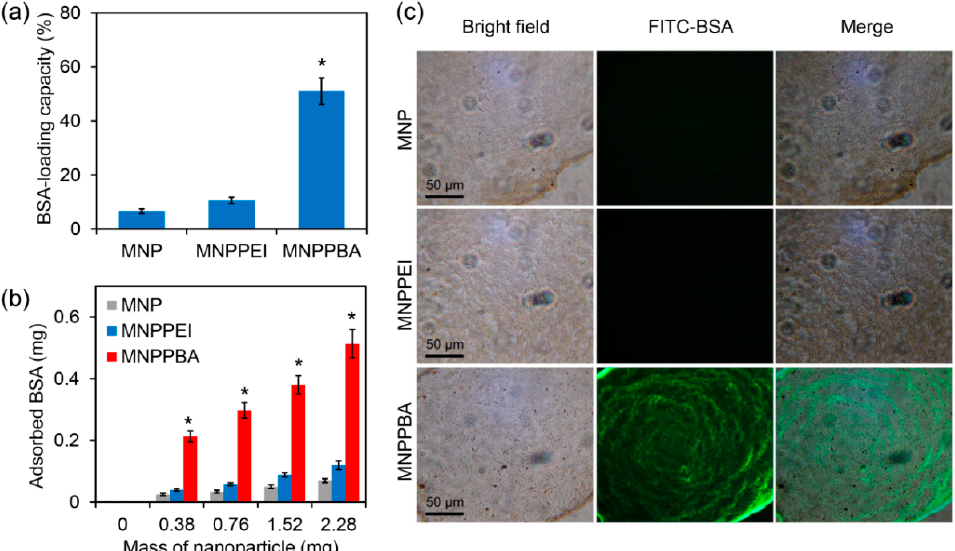
Figure 3. BSA capture by the synthesized nanoparticles. ( a ) BSA loading capacity of the nanoparticles (2.28 mg/mL) with the BSA solution (1 mg/mL) after 5 min of co-incubation. ( b ) BSA adsorption by the nanoparticles with different doses. ( c ) Fluorescence microscopy images of the nanoparticles after 5 min of co-incubation with the solution of FITC-labeled BSA. The asterisks (*) indicate a significant difference between MNPPBA and the other two groups ( p < 0.05).